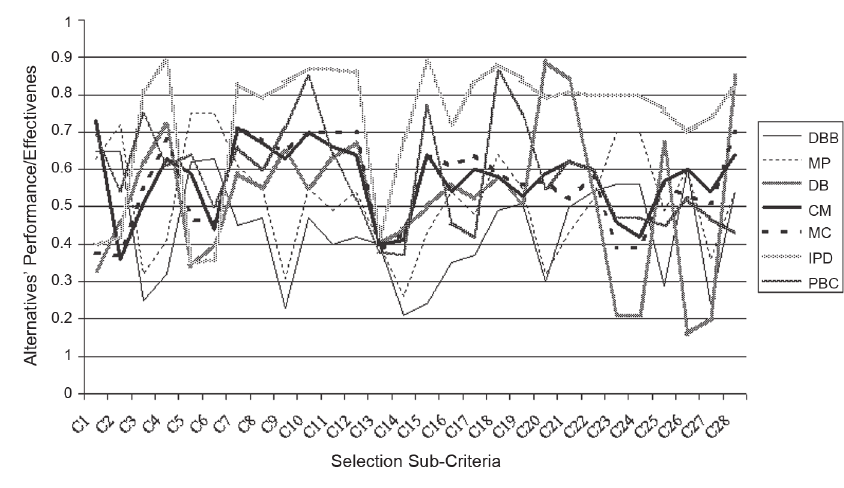
Fig. 3. Performance/effectiveness of procurement/delivery alternatives with respect to selection